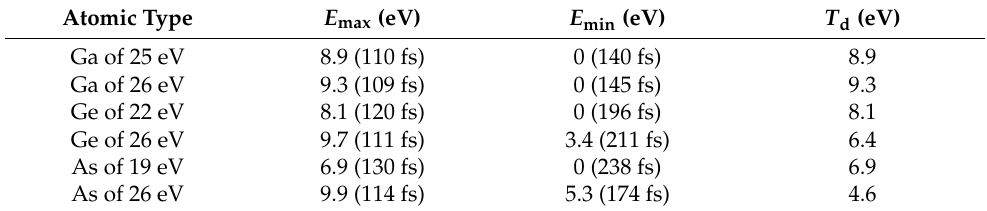
Table 1. The maximum values ( E max ) and minimum values ( E min ) of kinetic energy of the impacted C atom during and after collision, as well as the differences T d between E max and E min .